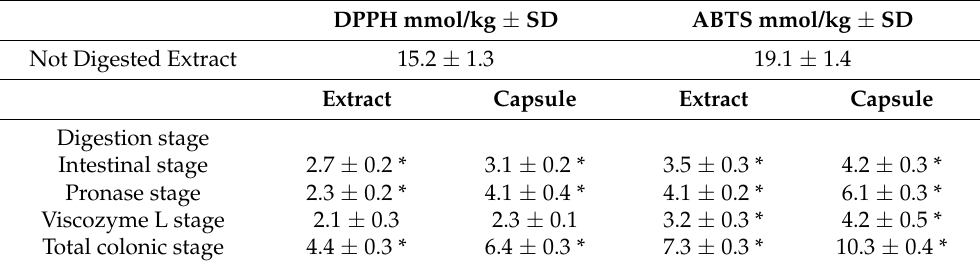
Table 4. Antioxidant capacity measured in broad bean hull extract encapsulated and non-encapsulated evaluated by DPPH and ABTS